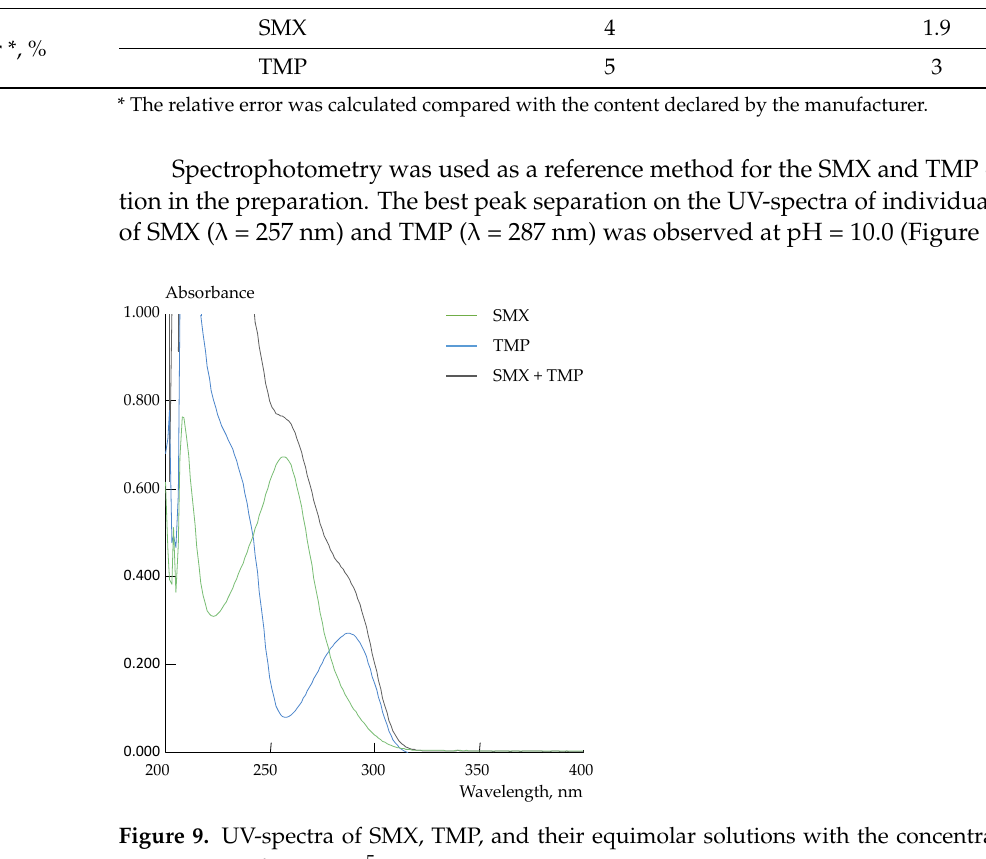
Table 4. The analysis of the Biseptol ® 120 mg (Adamed Pharma, Czosn ó w, Poland) using the spectrophotometric technique and the DP-sensor system based on MF-4SC/1.0 wt% CNTs-SO 3 − and MF- 4SC/1.0 wt% CNTs-NH 3+ membranes.